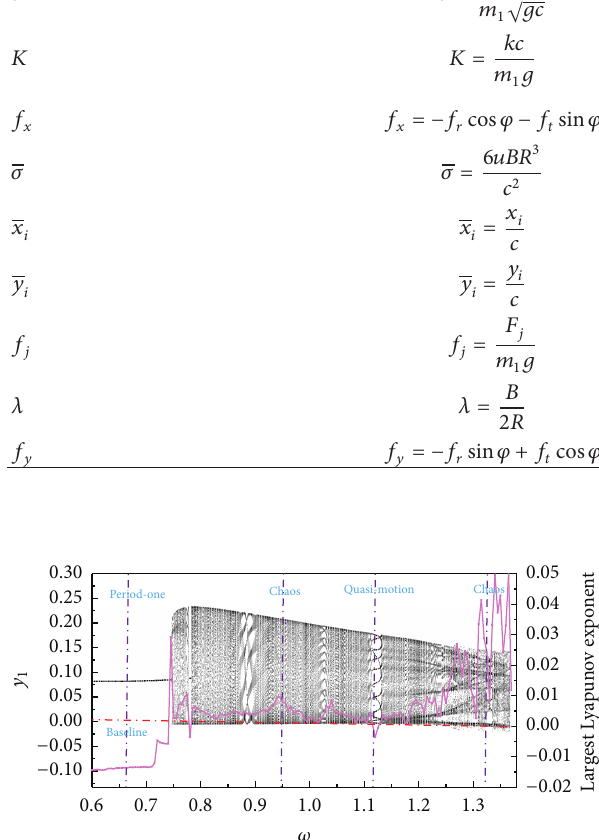
Figure 3: Bifurcation diagram of the steady-state response 𝑥 1 and its largest Lyapunov exponent.